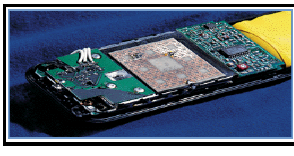
Figure 2: Fractal